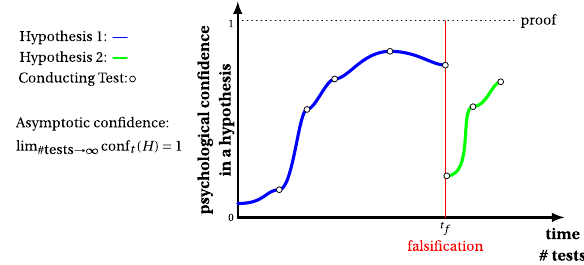
Fig. 2 Con fi dence in a hypothesis over the number of conducted tests (over time). If one of these tests falsi fi es the hypothesis (blue curve), it needs to be abandoned, and a new hypothesis (green curve) needs to be